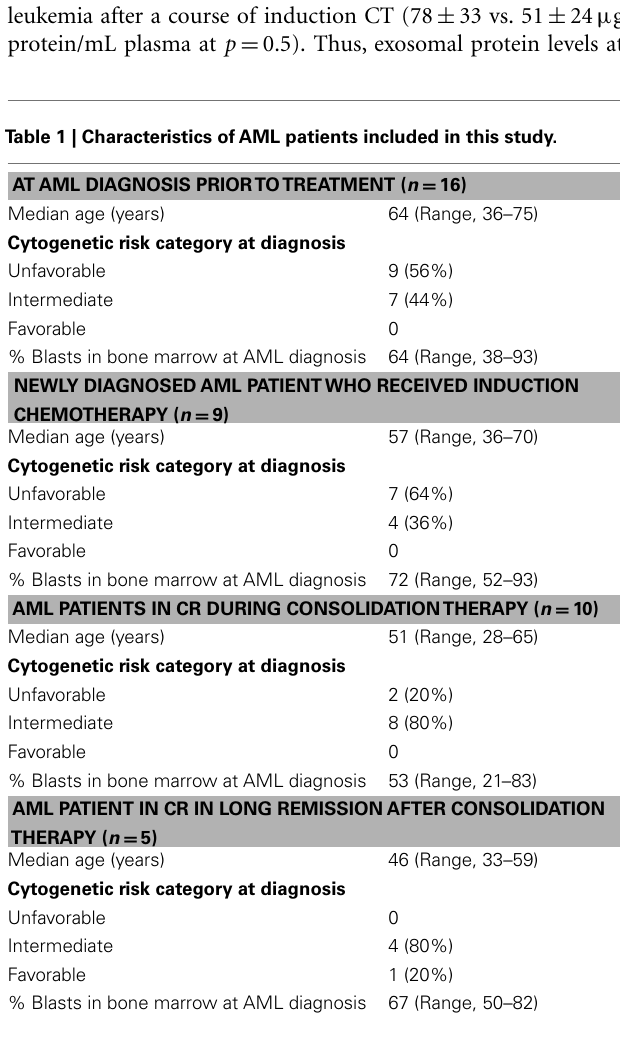
( Figure 1A ). The recovery of exosomes was 5 × 10 13 particles/mL plasma (NanoSight).